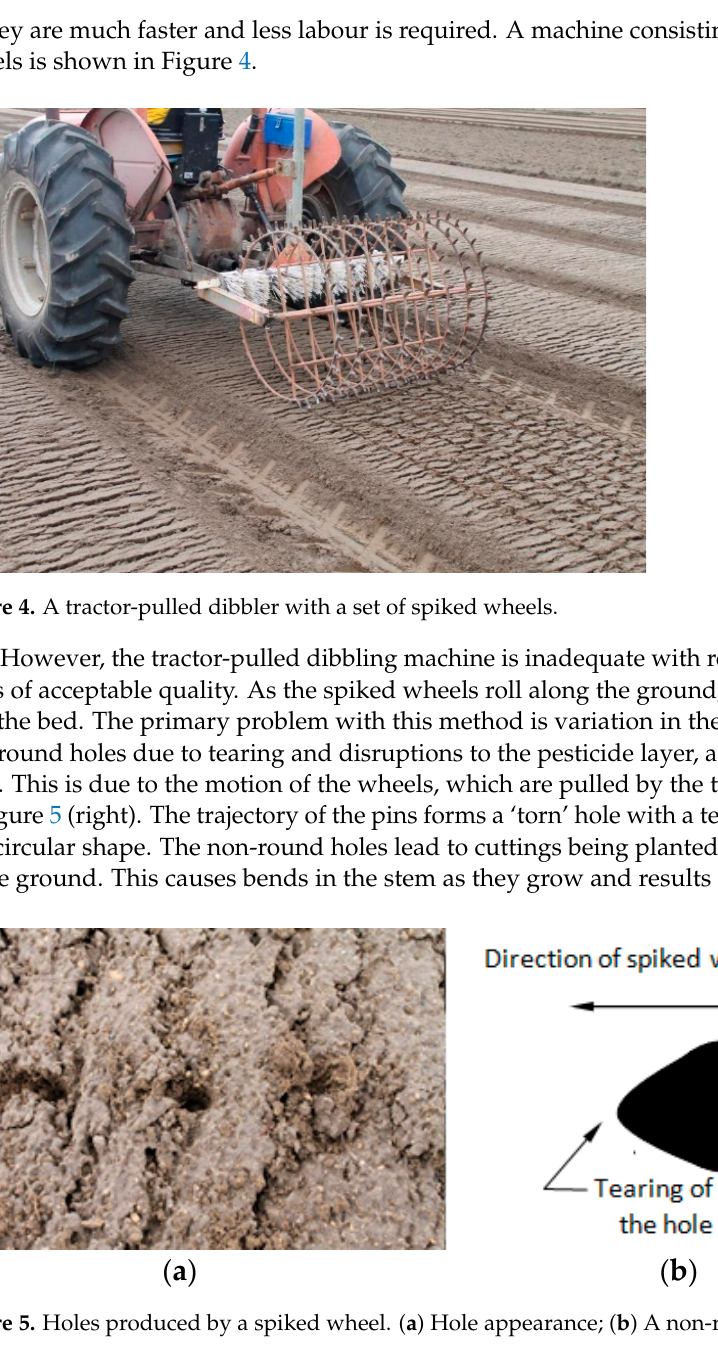
Figure 5. Holes produced by a spiked wheel. ( a ) Hole appearance; ( b ) A non-round hole. Dibbling is often used for seed planting and is often combined with an integrated seed- dropping mechanism. Typical applications include lettuce sowing [9–11], maize, redgram and cotton [12,13]. Performance increases have been achieved through mechanization of the process when compared to manual methods. For instance, an improvement in lettuce emergence with a pneumatic dibbler and seeder was observed when compared to a coulter drill [11]. Faster dibbling speeds have been shown, along with improved reliability of plant stands